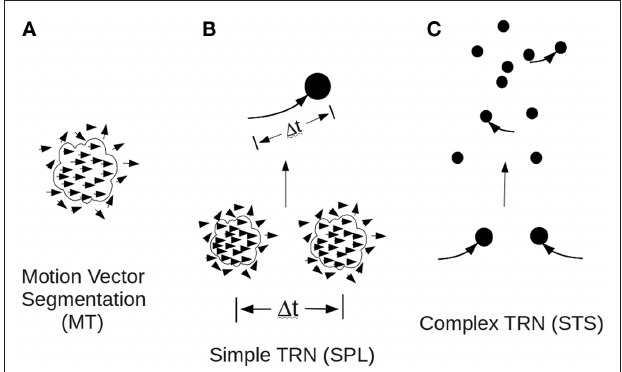
Figure 1 | Schematic representation of the specific trajectory recognition (STr) model of object individuation. (A) Compact areas of coherent instantaneous velocity are segmented in MT. (B) “Simple” trajectory recognition networks (TRNs) respond to specific paths of coherent instantaneous-velocity segments in the MT-defined space, with a time resolution of ∆ t on the order of the VSTM consolidation time. Simple TRNs appear to be components of or originate in SPL. (C) “Complex” TRNs respond to specific correlations between simple TRN activity, and appear to be components of or